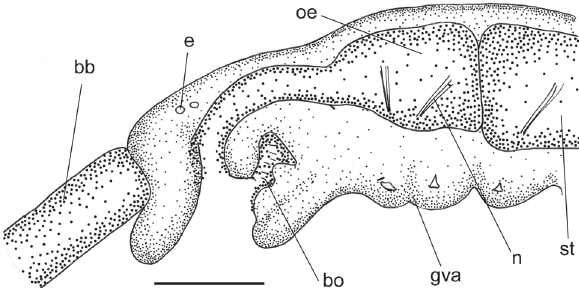
Figure 1. Nicolea uspiana : anterior end of a postlarval specimen. (bb) Buccal tentacle, (bo) buccal organ, (e) eyespot, (gva) glan- dular ventral area, (n) notochaeta, (oe) oesophagus, (st) stomach. Scale bar: 0.1